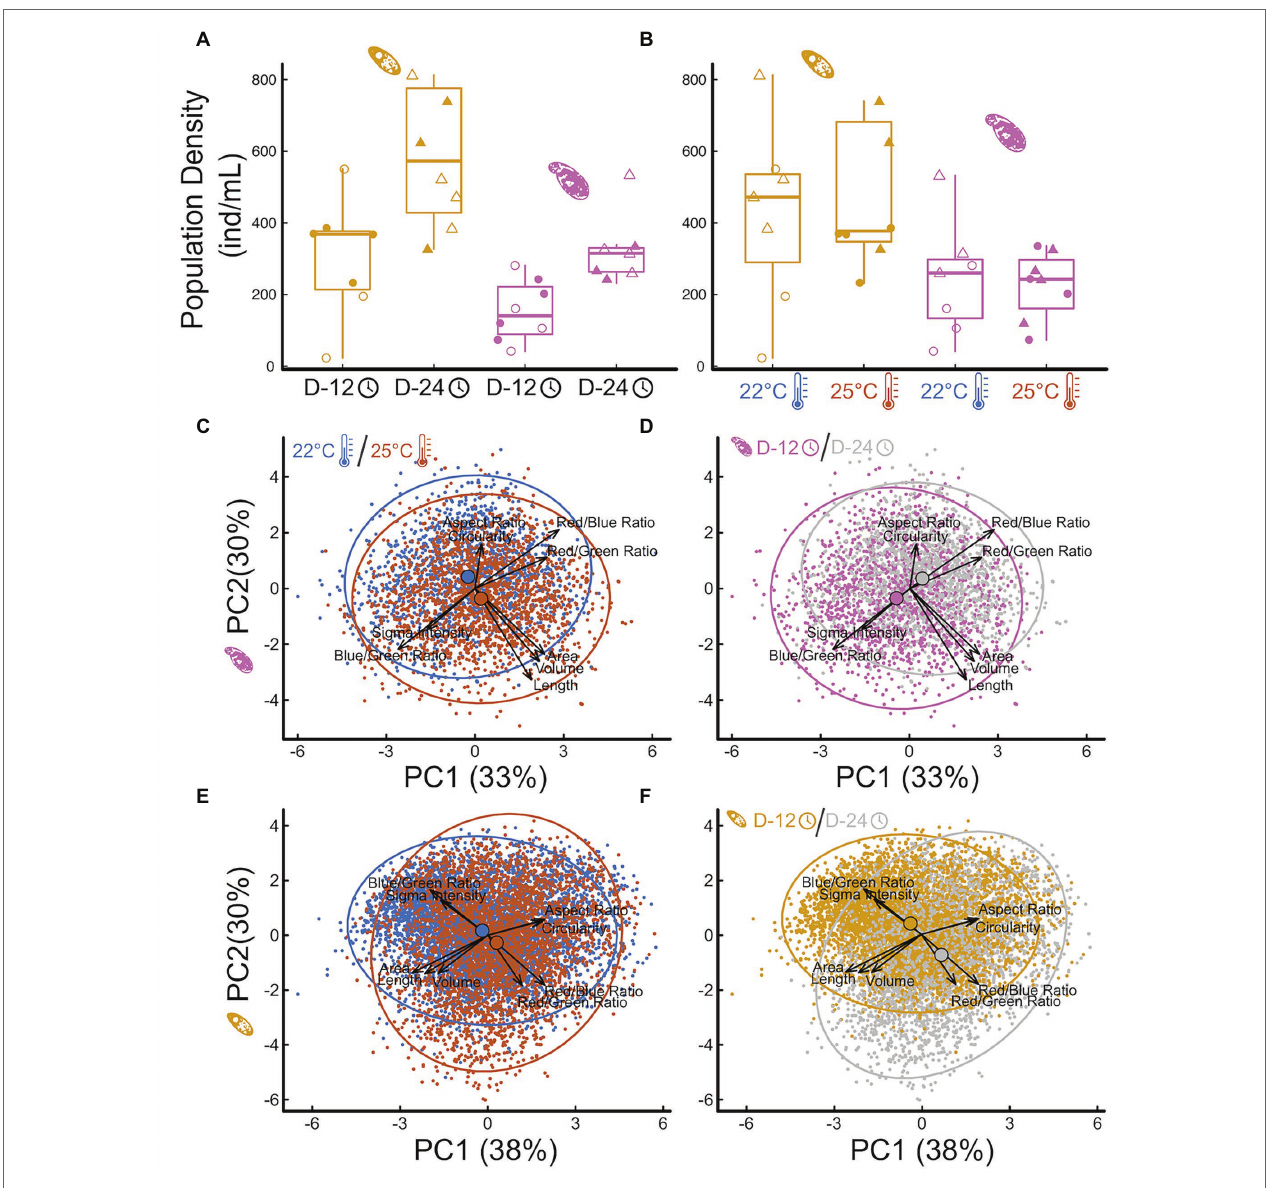
FIGURE 3 | Impact of temperature treatments and incubation time on protist density and morphology. The effect of incubation time (A) and temperature treatment (B) on Tetrahymena (yellow) and Colpidium (pink) density (cells/mL) in the microcosms, and principal component analysis of multivariate protist phenotypes (C–F) : Colpidium (C,D) and Tetrahymena (E,F) , colored by temperature (C,E) and by time (D,F) . Vectors represent the principal components loadings of each measured phenotypic characteristic, including shape, size, optical depth, and